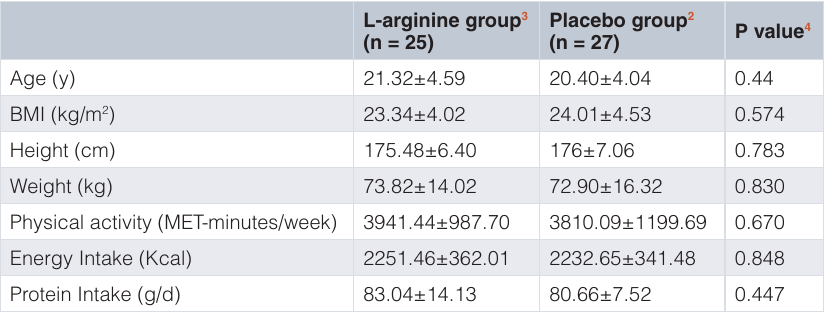
Table 1. General baseline characteristics of athletic men who received either L-arginine supplements or placebo 1 .